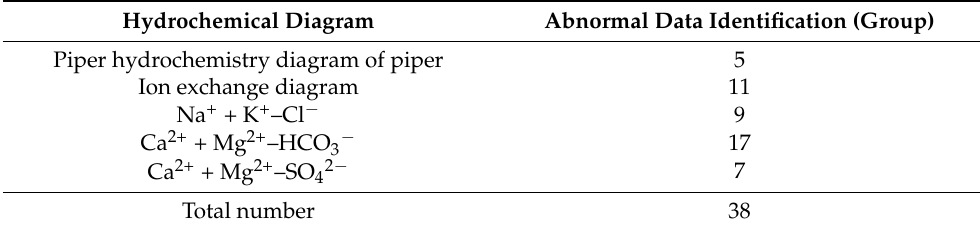
Table 2. Identification of abnormal water chemical data from the hydrochemical diagrams.